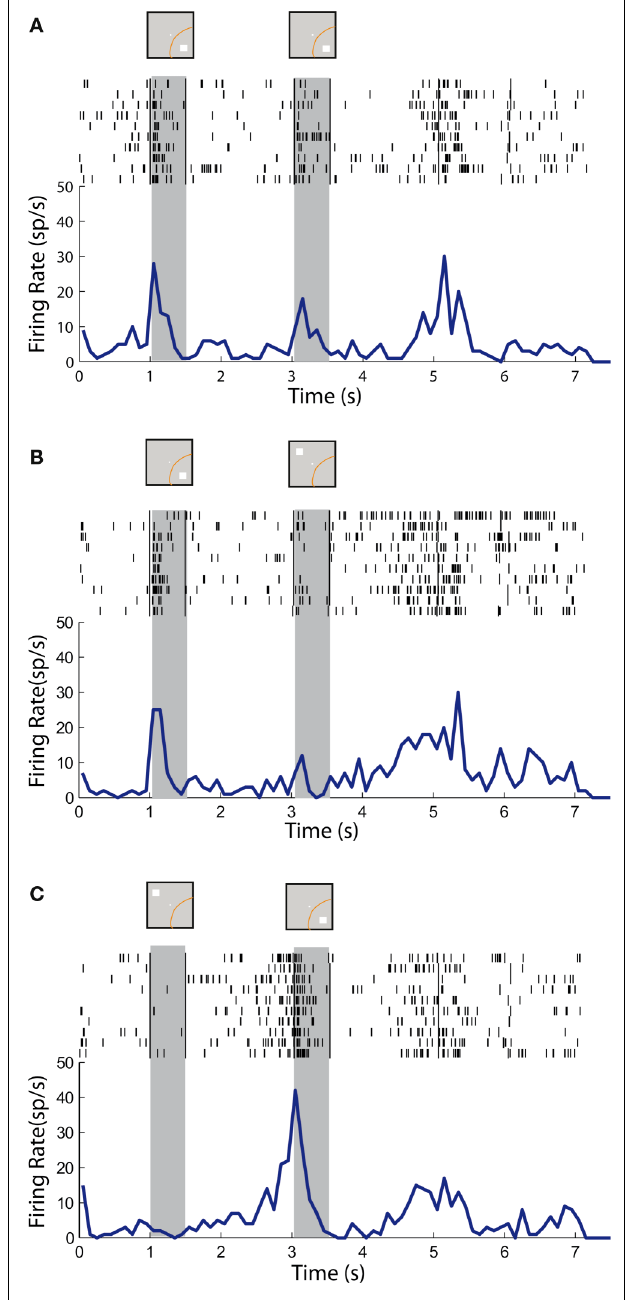
FIGURE 3 | Rasters and histograms of one neuron with sustained activity recorded from area 7a of the posterior parietal cortex. Gray bars represent times of stimulus presentations. Insets on top of gray bars indicate stimulus location relative to the receptive fi eld (orange curve). Two sets of vertical lines in the rasters represent onset of Choice Targets and delivery of reward. (A) Responses to the cue followed by a match stimulus in the receptive fi eld. (B) Responses to the cue in the receptive fi eld followed by a nonmatch stimulus out of the receptive fi eld. (C) Responses to the cue out of the receptive fi eld, followed by a nonmatch in the receptive fi eld.